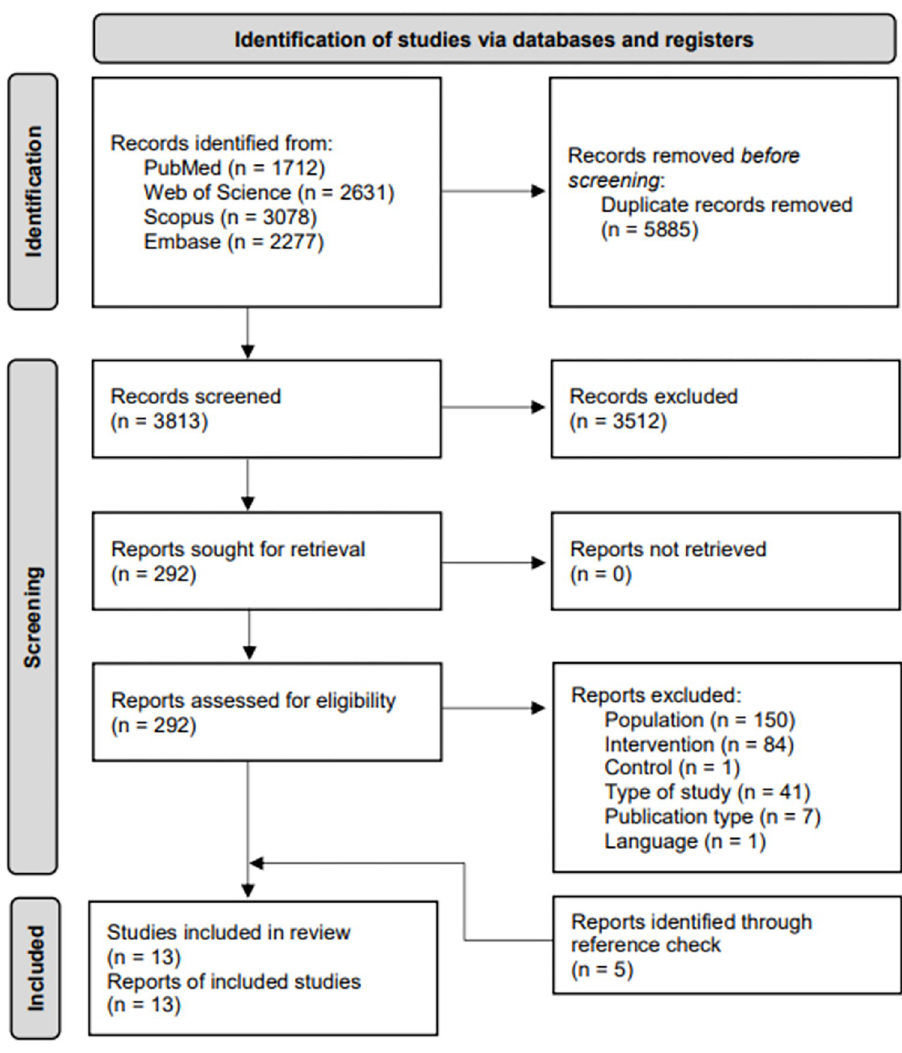
Fig 1. Prisma flow diagram of the study selection. N =